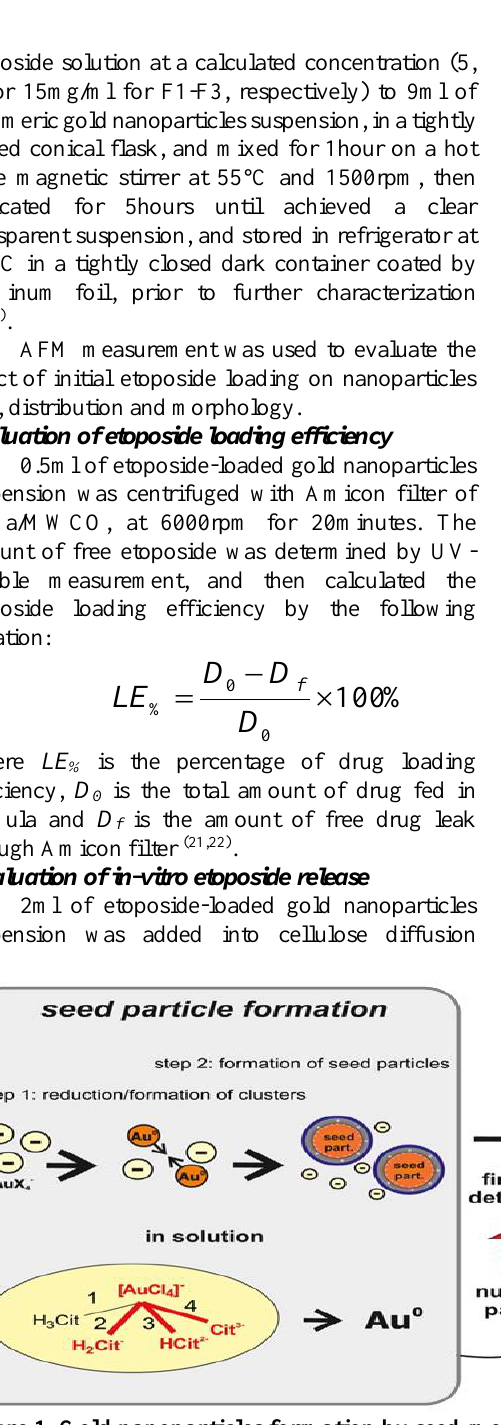
Citrate has three carboxyl groups, which can be protonated/deprotonated leading to an acid base buffer. In addition, citrate can be irreversibly oxidized to faster reducing agent (dicarboxy acetone). Citrate was interplay many chemical and physicochemical processes which initiate and also terminate of seed particles formation. While gold ions Au +3 exist in different chemical species